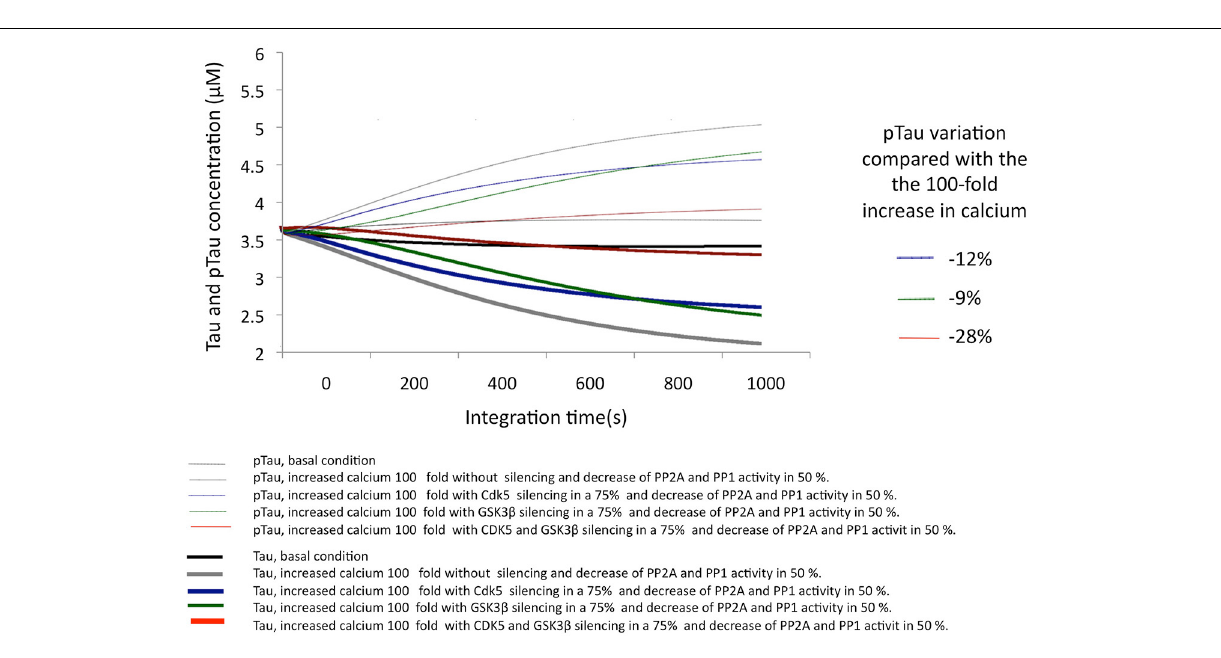
activity. CDK5 and GSK3 β were silenced by 75%. The inset in the graph indicates the decrease in pTau in response to increased